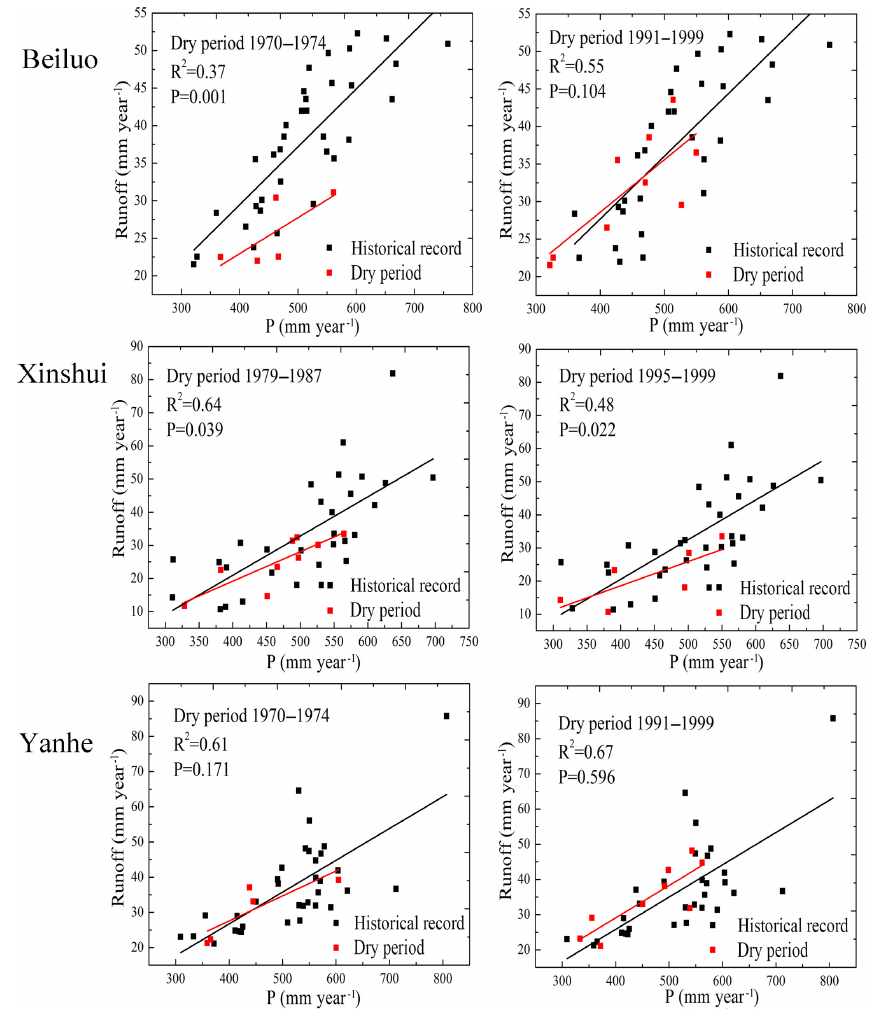
Figure 5. The annual precipitation–runoff scatter plot for each